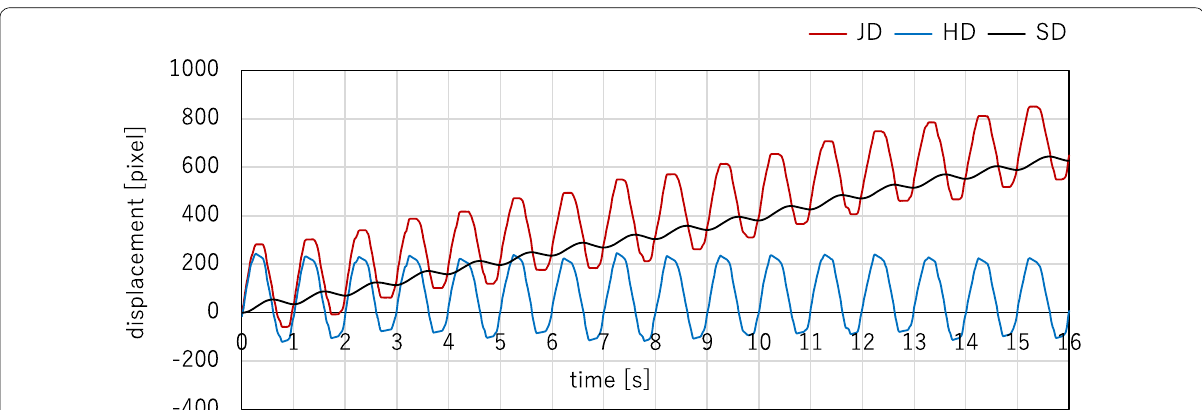
Fig. 9 Jitter displacement (JD), filtered high-frequency component (HD), and stabilized displacement (SD) when observing a photographic